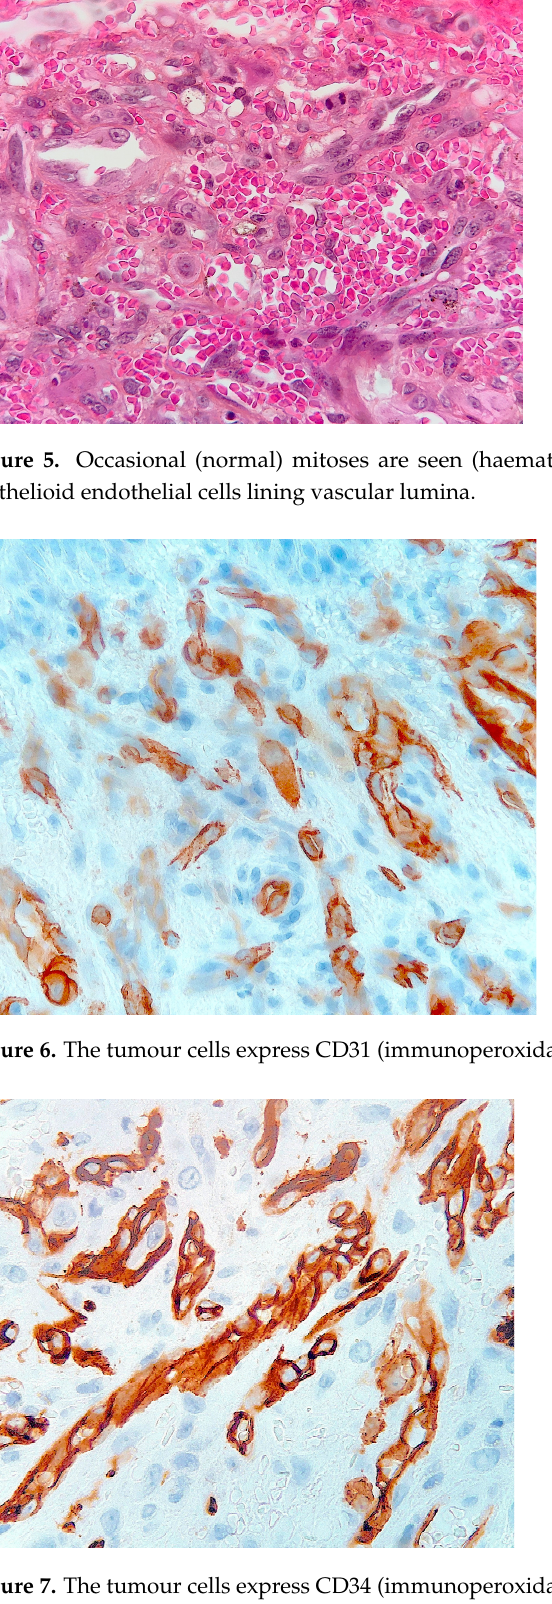
Figure 8. The tumour cells express nuclear reactivity for ERG (immunoperoxidase revealed with diaminobenzidine).